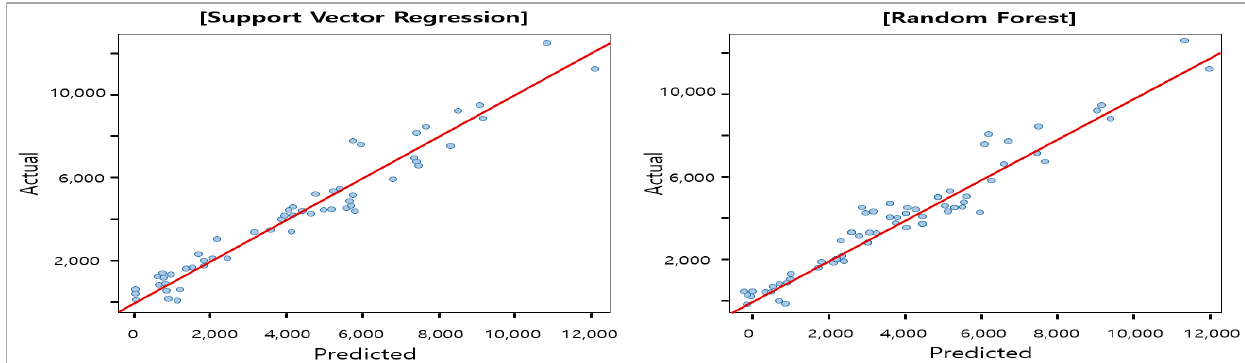
Figure 8. Comparison of T/C option prices (L: BSM, R: ANN).